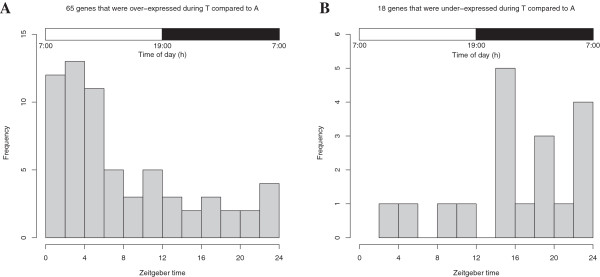
Distribution of circadian phases of differentially expressed genes in torpor vs. arousal episodes. Open and filled bars symbolize light (mice are asleep) and dark (mice are active) phases. Circadian peaks of genes that were over-expressed in torpor appeared mostly in the light phase (A) and circadian peaks of genes that were under-expressed in torpor appeared mostly in the dark phase (B). T: torpor; A: arousal episodes.